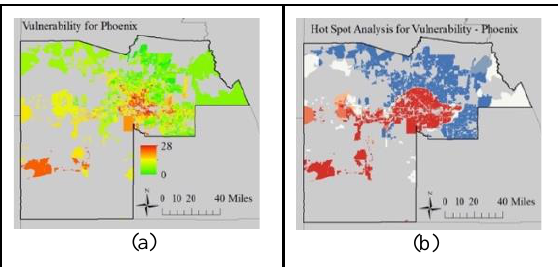
Figure 8. Socio-economic vulnerability map and hot spot analysis for Maricopa County 2018.